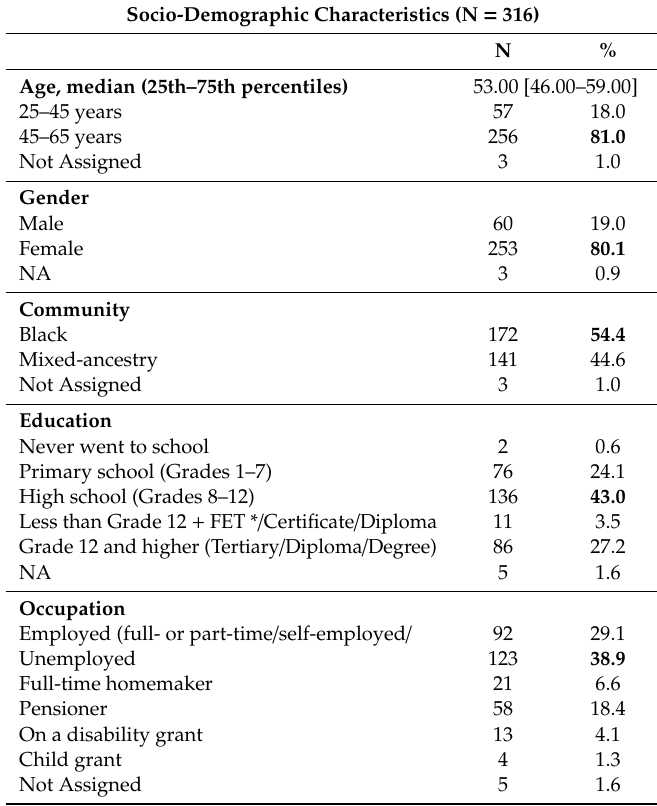
Table 2. Socio-demographic characteristics of at-risk type II diabetes black and mixed-ancestry communities in Cape Town, 2018 (N =